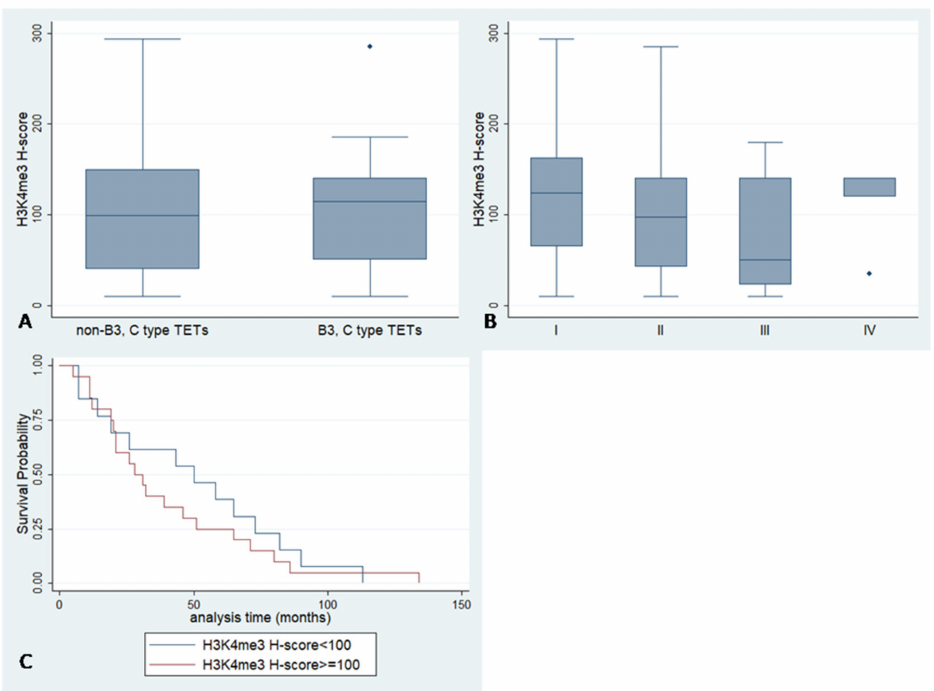
Figure 5. ( A , B ) H3K4me3 Histone H-score according to WHO subtype (Mann–Whitney U test, p > 0.10) and Masaoka–Koga stage (Kwallis ANOVA, p > 0.10) ( C ) Kaplan–Meier survival curves according to H3K4me3 H-score (log-rank test, p > 0.10). Small diamonds in ( A , B ) correspond to